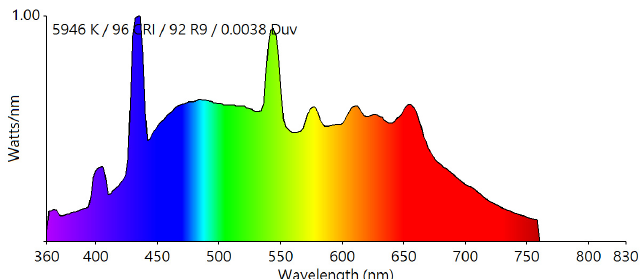
Figure 7. TQC Chinese typing test software ( a ) For typing software interface, the text displayed at the top of the interface should be entered into the blue box at the bottom; ( b ) At the end of the typing test, the result screen will provide the average word count and error rate at the end of the text.